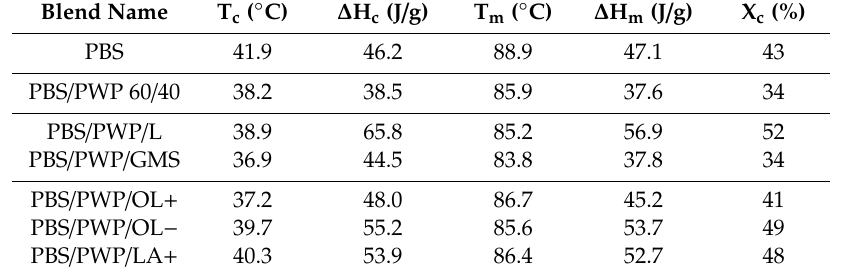
Table 3. Results of differential scanning calorimetry analysis (second heating and cooling).